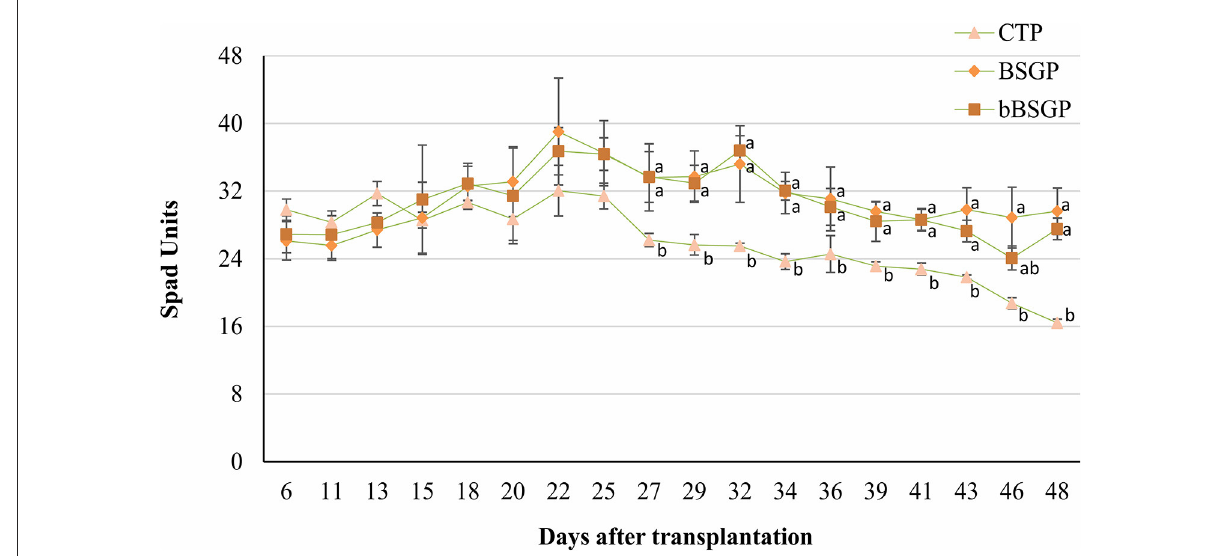
FIGURE2 Effect of the biomasses on chlorophyll content of escaroles grown in control soil (CTP), soil amended with native (BSGP) or bioprocessed brewers’ spent grain (bBSGP). a,b Different letters indicate significant differences among the data according to HSD test. Vertical bars represent standard